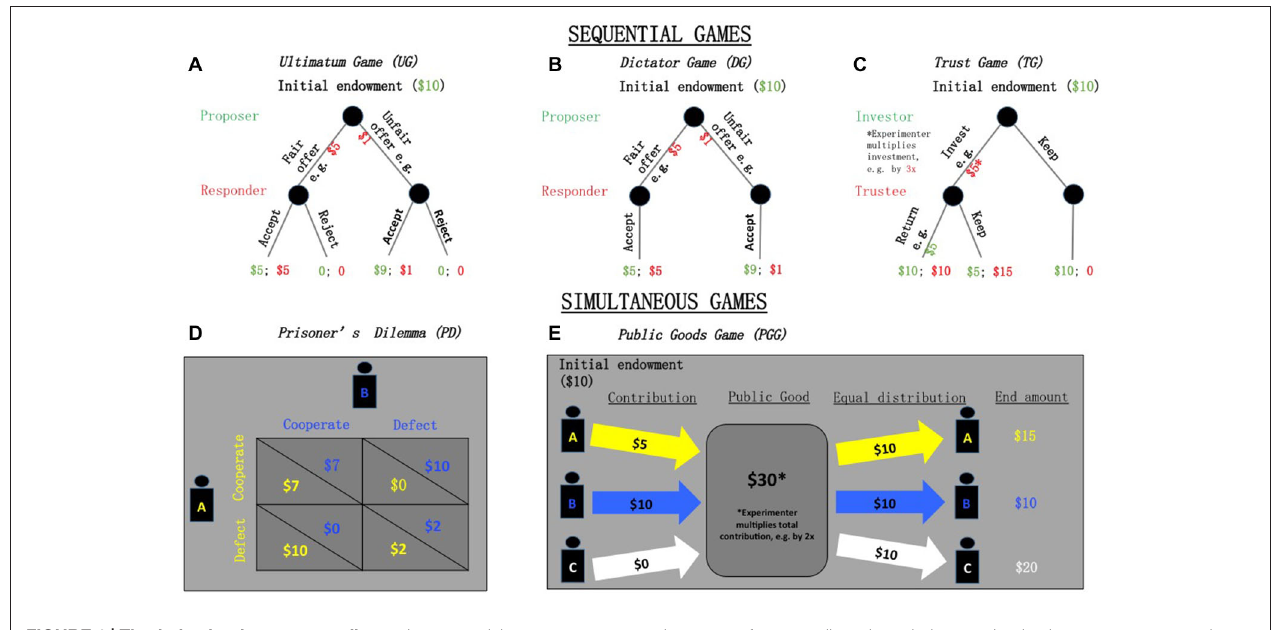
FIGURE 1 | The behavioral game paradigms . In sequential games, such as the ultimatum game (UG) (A) , dictator game (B) , and trust game (C) , games are played sequentially, i.e., players move one at a time and